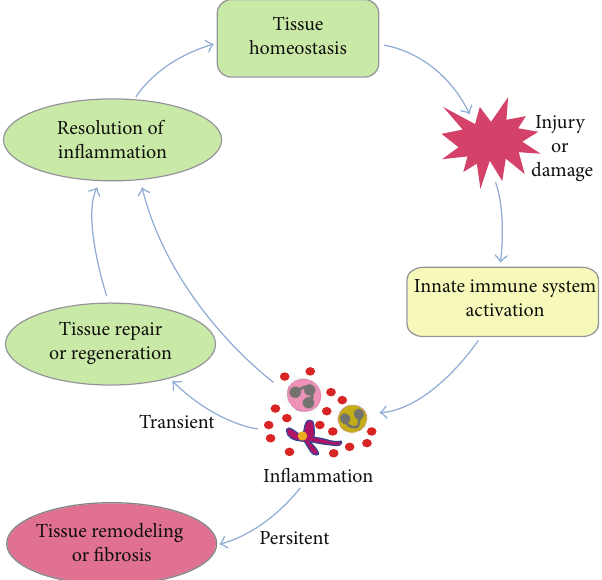
Figure 1: The role of the innate immune system in regaining tissue homeostasis. An injury disturbs the tissue homeostasis and activates the innate immune system leading to the recruitment of several immune cells at the site of injury. These immune cells secrete cytokines,growthfactors,andenzymestoestablishaninflammatory milieu. They also secrete anti-inflammatory and proregenerative cytokines to promote resolution of inflammation as well as tissue repair. A transient inflammation is often helpful to get rid of the cause of the tissue injury and return to homeostasis. However, an uncontrolled or persistent inflammation promotes tissue remodel- ing and